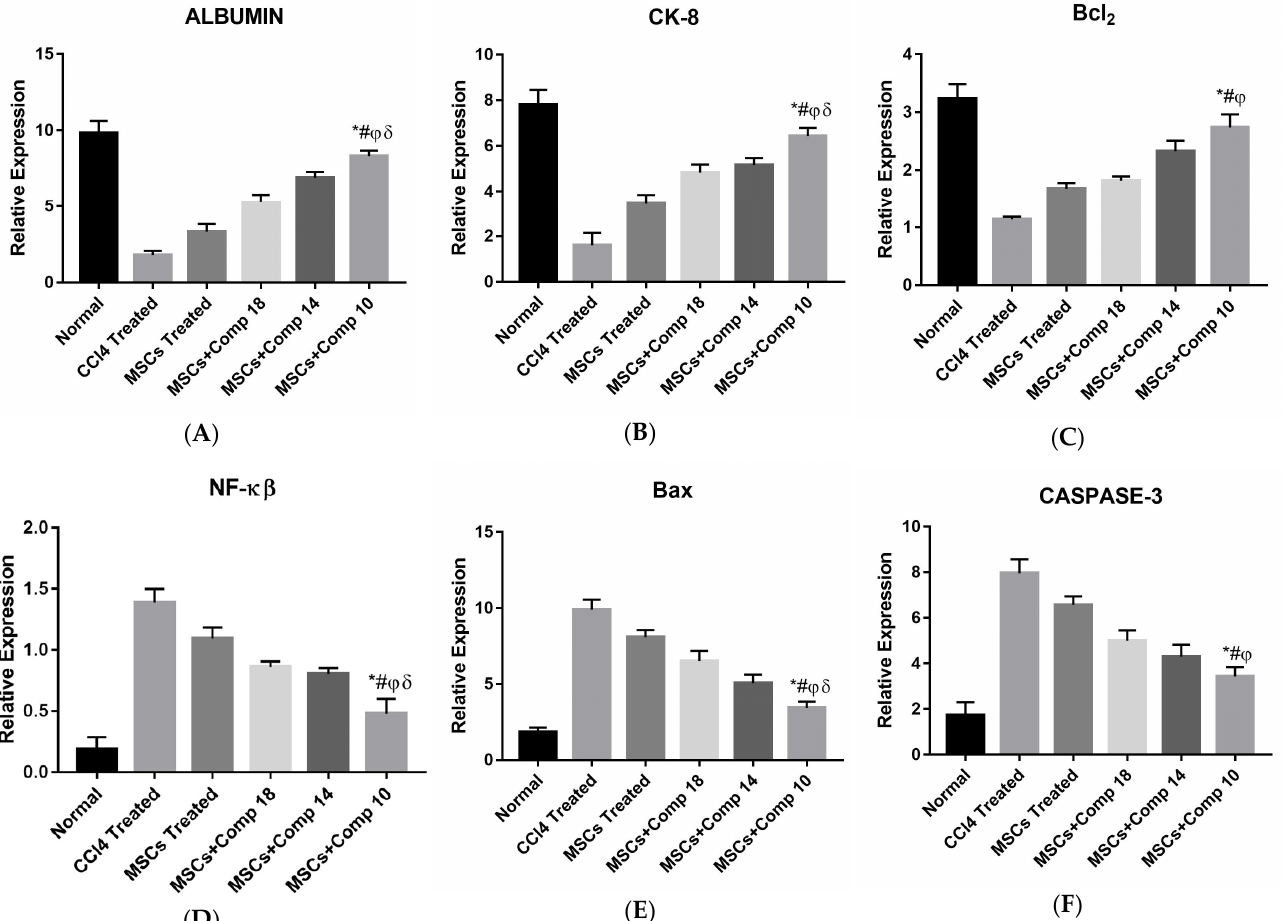
Figure 2. Real-time PCR analysis of in vitro hepatocytes co-cultured with MSCs + compounds. Expression of normal hepatic genes (albumin ( A ) and CK-8 ( B )) and anti-apoptotic ( BCl 2 ( C )) markers genes was increased and apoptotic ( BAX ( E ), caspase-3 ( F ) and NF- κ B ( D )) genes decreased in MSCs + compounds-treated hepatocytes, especially in the case of + MSCs + compound ( 10 )-treated hepatocytes, as shown by bars with symbols *. Mean ± SEM (n = 3). Bars with symbols show significance with each other. * p < 0.02 for MSCs + Comp10 vs. CCl4; # p < 0.05 for MSCs + Comp10 vs. MSCs; ϕ p < 0.05 for MSCs + Comp10 vs. MSCs+Comp18; δ p < 0.05 for MSCs + Comp10 vs. MSCs +